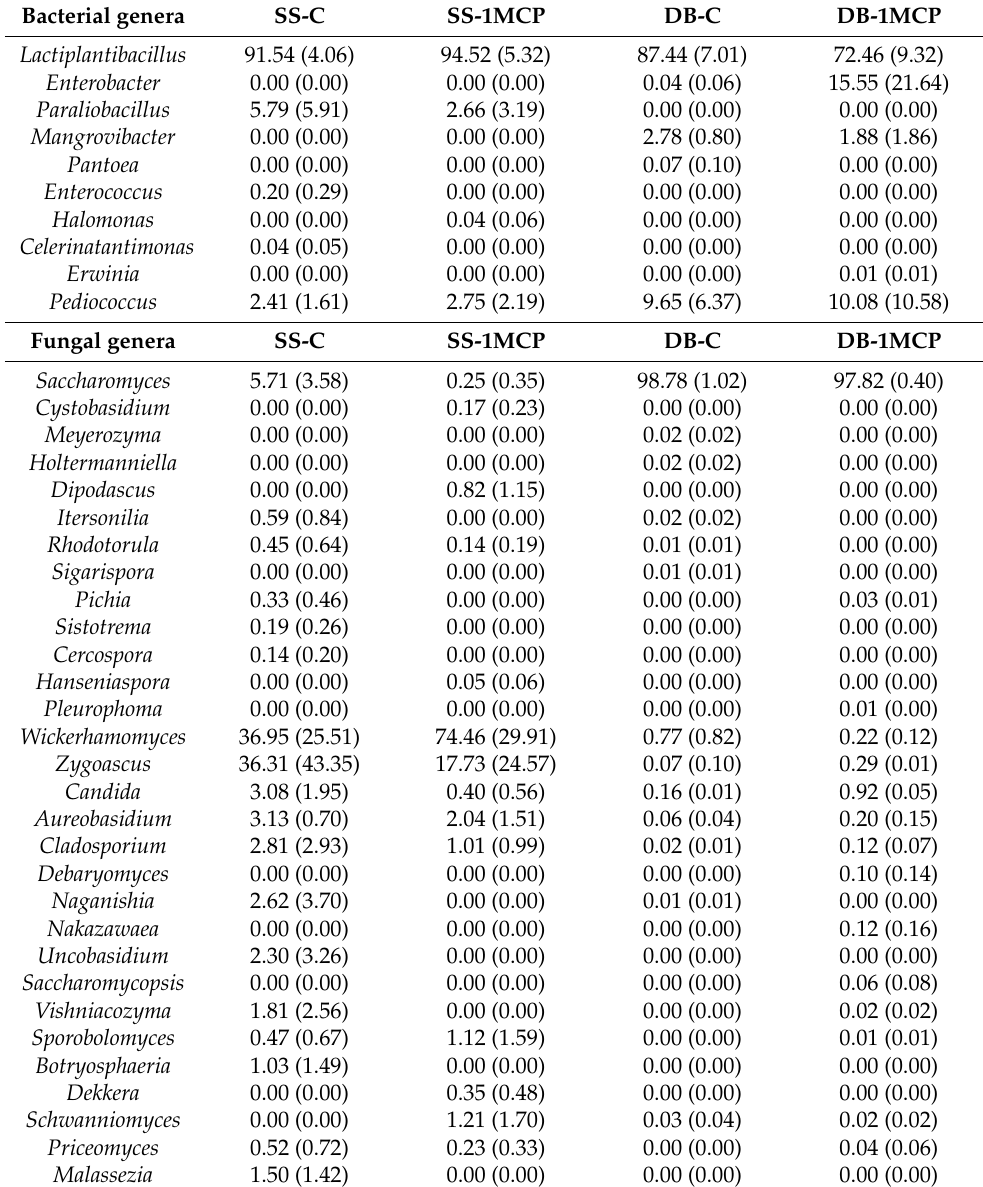
Table 1. Relative abundance (%) in olive biofilms of bacterial and fungal genera at the end of the fermentation process (176